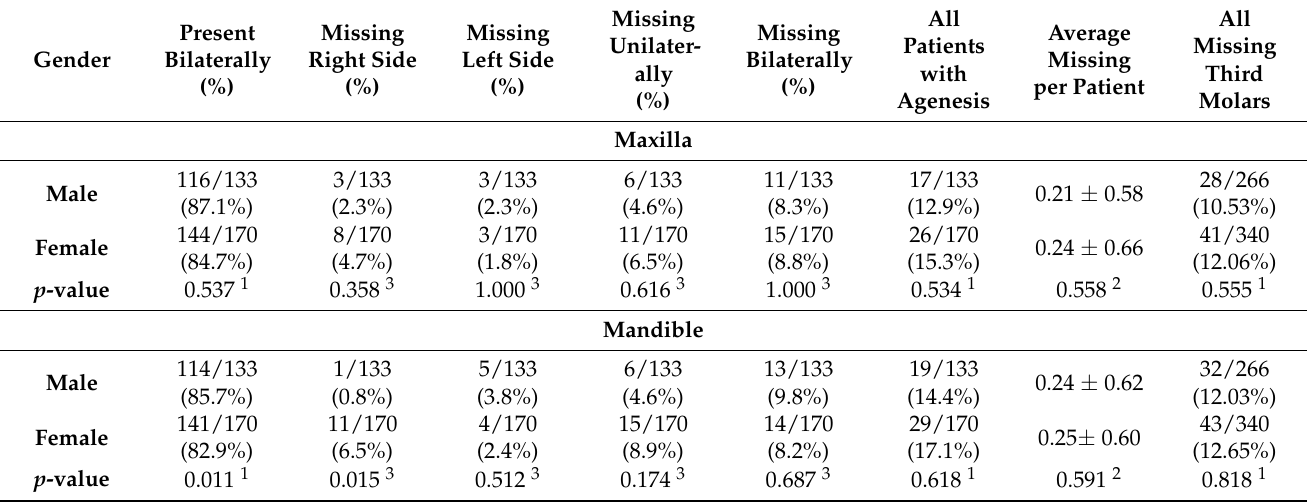
Table 5. Distribution of the symmetry patterns of third molar agenesis per jaw in males and females without agenesis of teeth other than the third molars, overall and for each